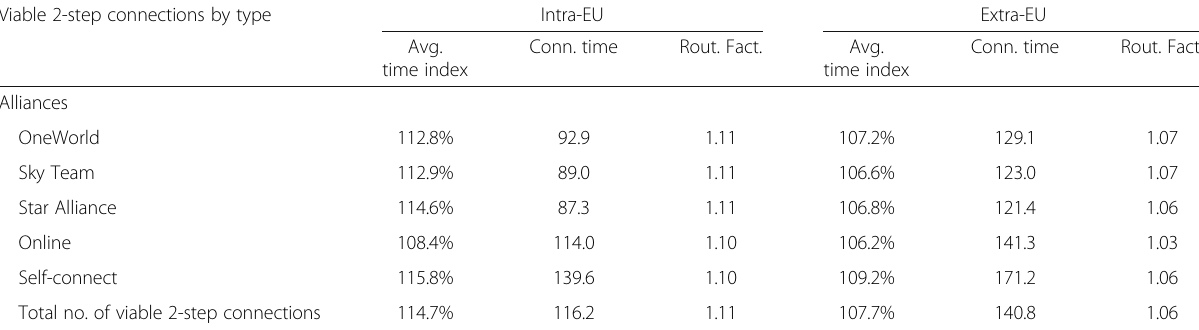
Table 3 Number of viable 2-step connections and their time-performance (Avg. time index: increase in travel times above the quickest alternatives), average connecting times and routing factors by type of connections and for geographical areas Viable 2-step connections by type